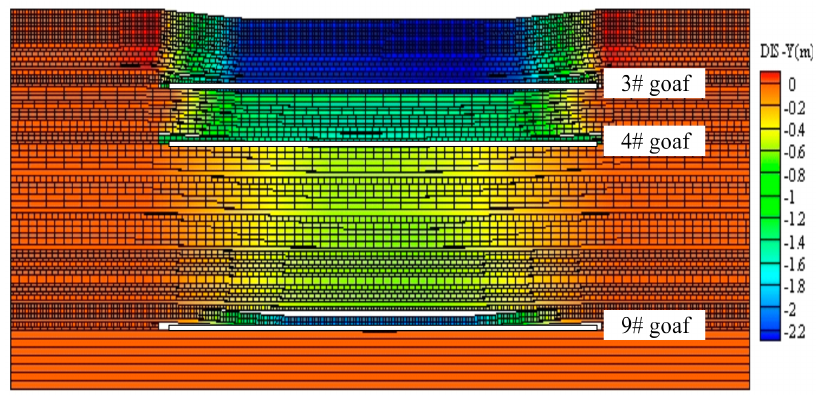
Figure 21. Displacement field of overburden after the mining of the 9# coal seam.